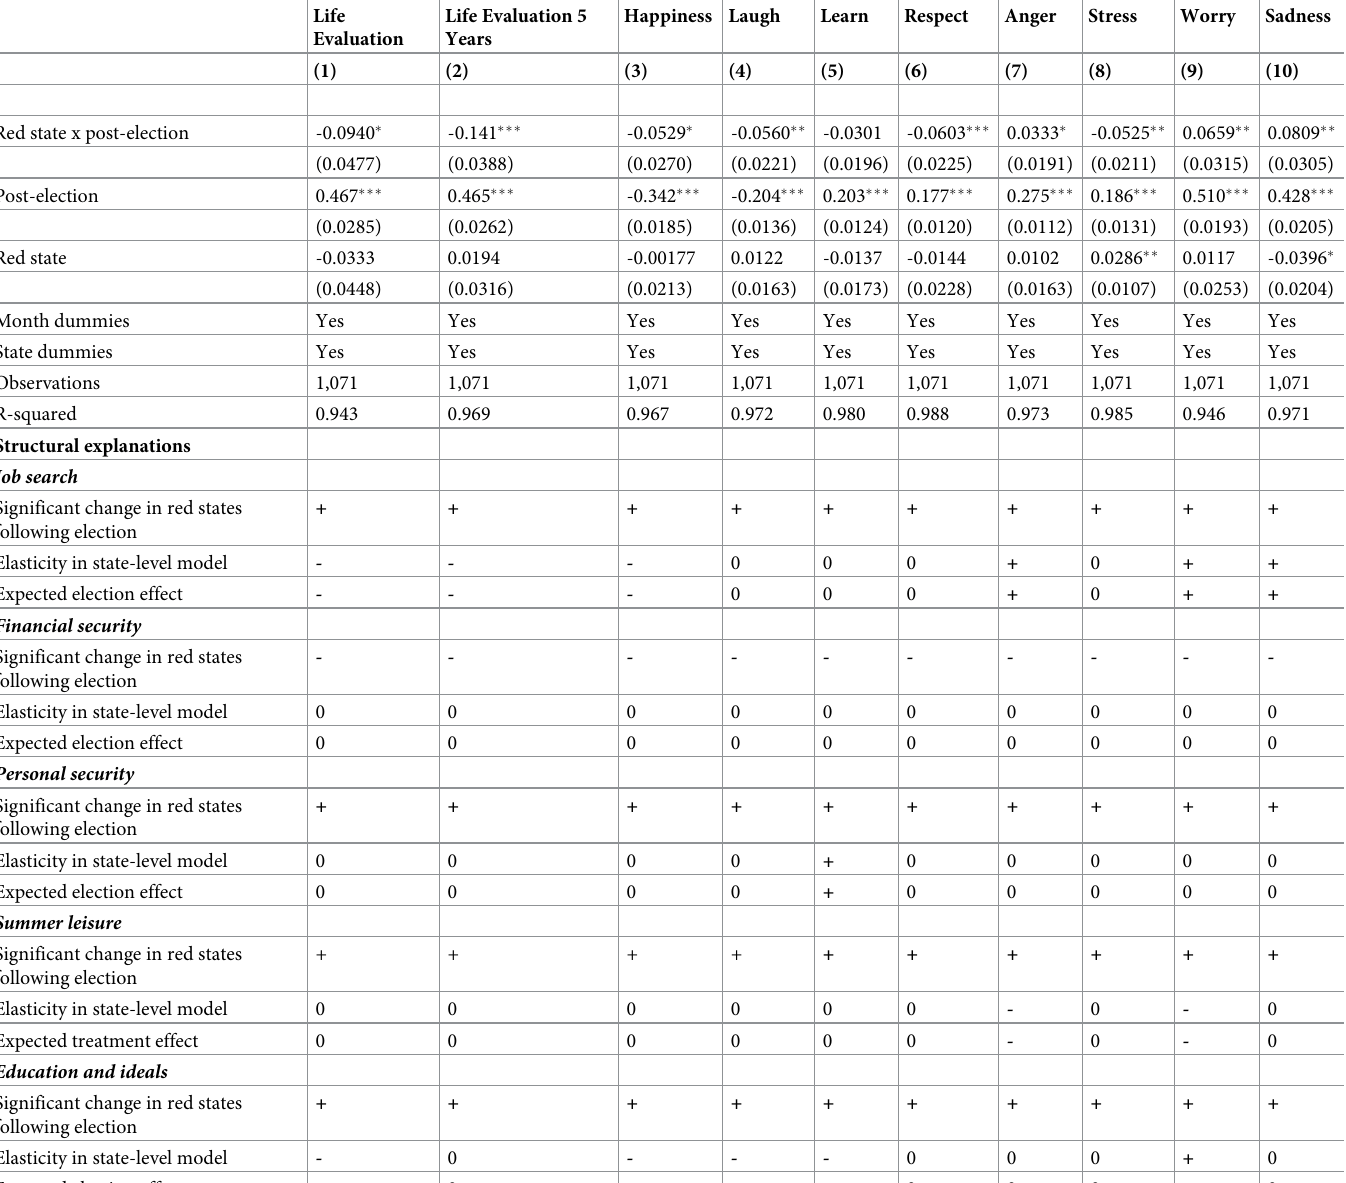
Table 7. Well-being in red states following election of Barack Obama.